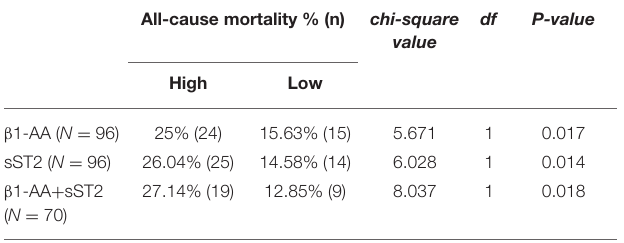
TABLE 3 | The relationship between levels of the β 1-AA, sST2 and the all-cause mortality in patients with ADHF by Chi-square analysis. df All-cause mortality % (n) chi-square value